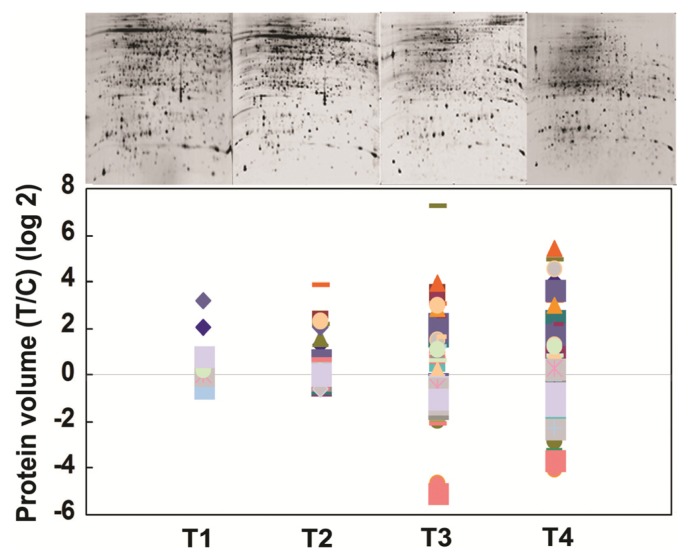
Abundance of brown planthopper (N. lugens) responsive proteins in IR64 at different days after BPH infestation (DAI) (T1 = 2 DAI; T2 = 13 DAI; T3 = 28 DAI; T4 = 34 DAI). The figure shows log2 values of proteins [BPH infested (T)/control (C)] at different time points. (n = 3; p < 0.05). The protein legends in the figure represent induction response of IR64 proteins (log 2 value) after BPH infestation